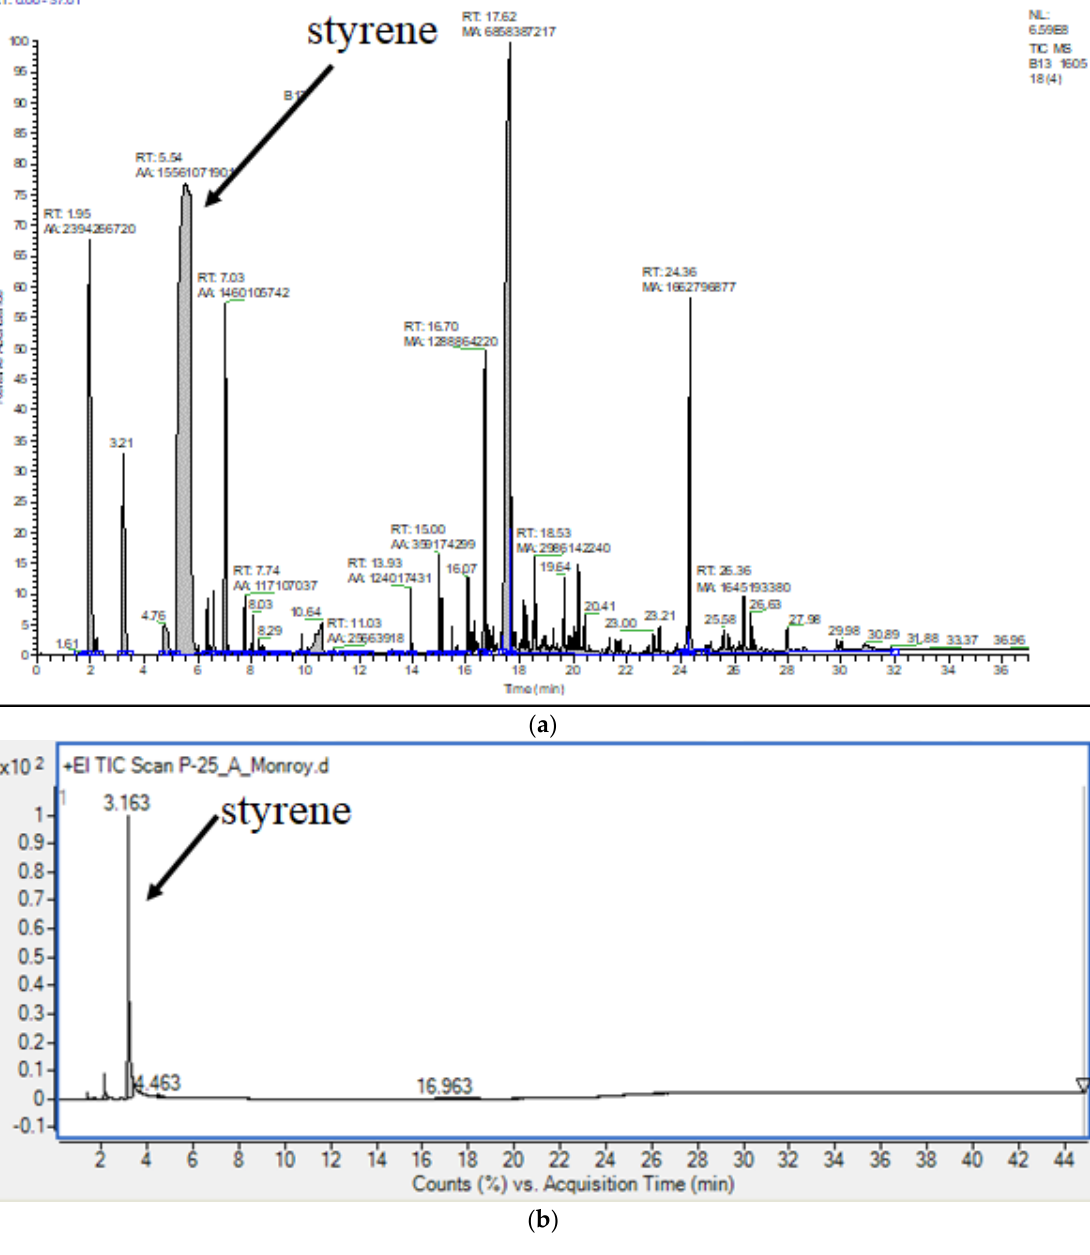
Figure 2. Gas chromatographs of the liquid fraction pyrolysis product: ( a ) previous process; ( b ) current process.